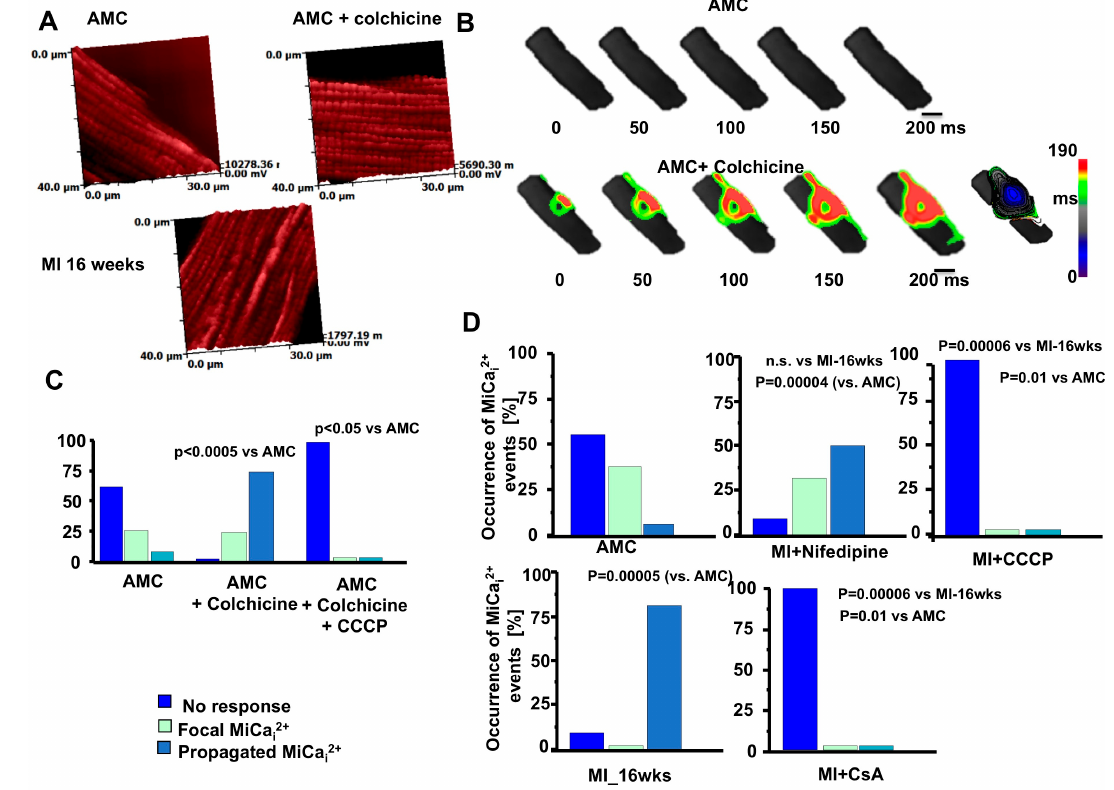
Figure 5. Microtubule network derangements together with mitochondrial displacement are prerequisite for mechanically induced Ca 2+ release initiation. ( A ) TMRM-labelled mitochondria position in AMC, AMC+colchicine, and HF (MI-16 weeks); ( B ) Mechanically induced Ca 2+ initiation in AMC cell (top) and the same cell in the presence of colchicine (bottom); ( C ) Occurrence of MiCa i events in terms of no response, focal MiCa i and total MiCa i in AMC, AMC+colchicine, AMC+colchcine+CCCP; ( D ) Same as C for AMC, MI-16 wks, MI-16-wks + Nifedipine, MI-16-wks + CCCP, MI-16-wks + CsA. Modified from [6] with permission.